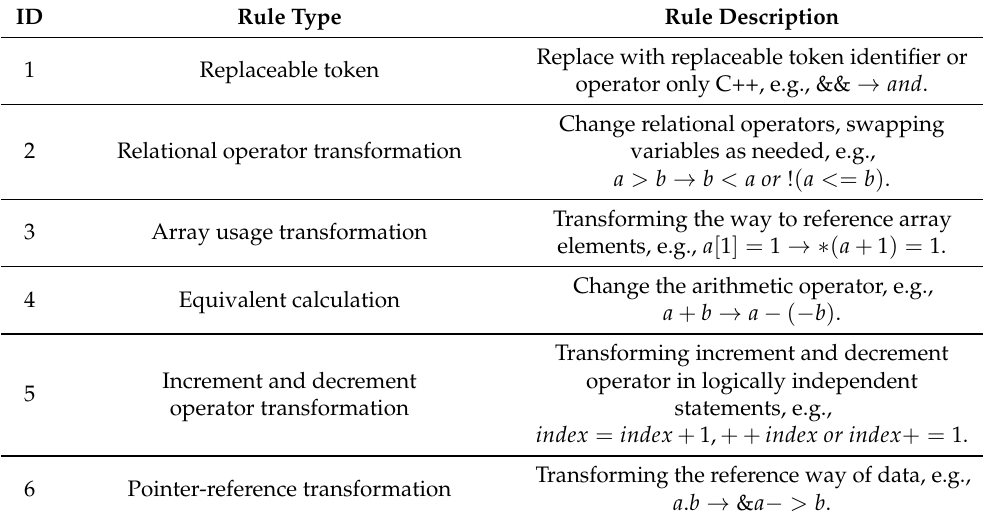
Table 1. Operator transformation rules